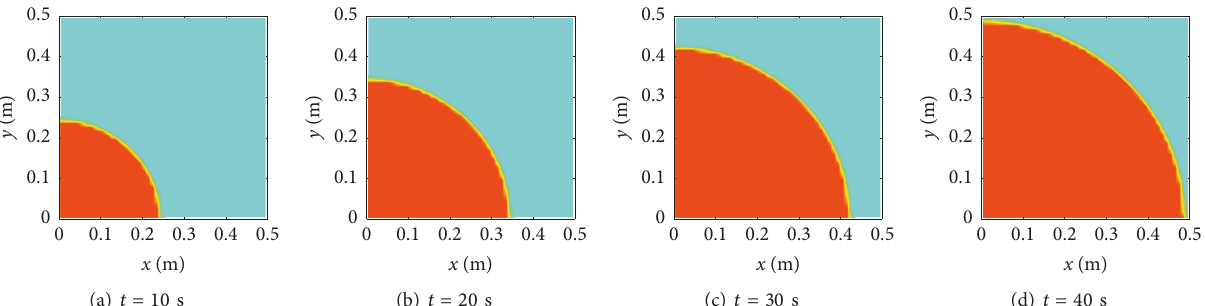
Figure 5: Simulated grout diffusion process by quasi-3D model in Case 1.